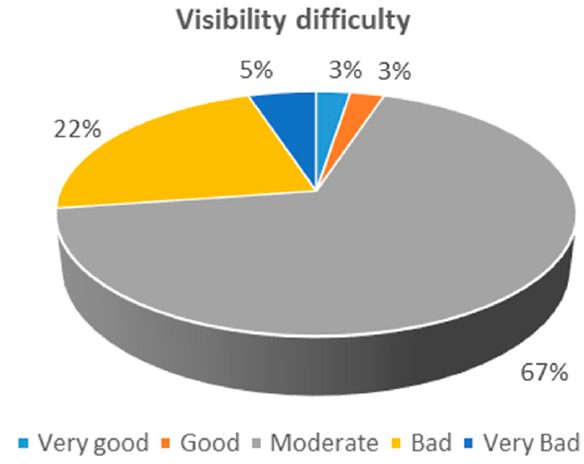
Figure 26. Visibility during evacuation under smoke-filled environment.